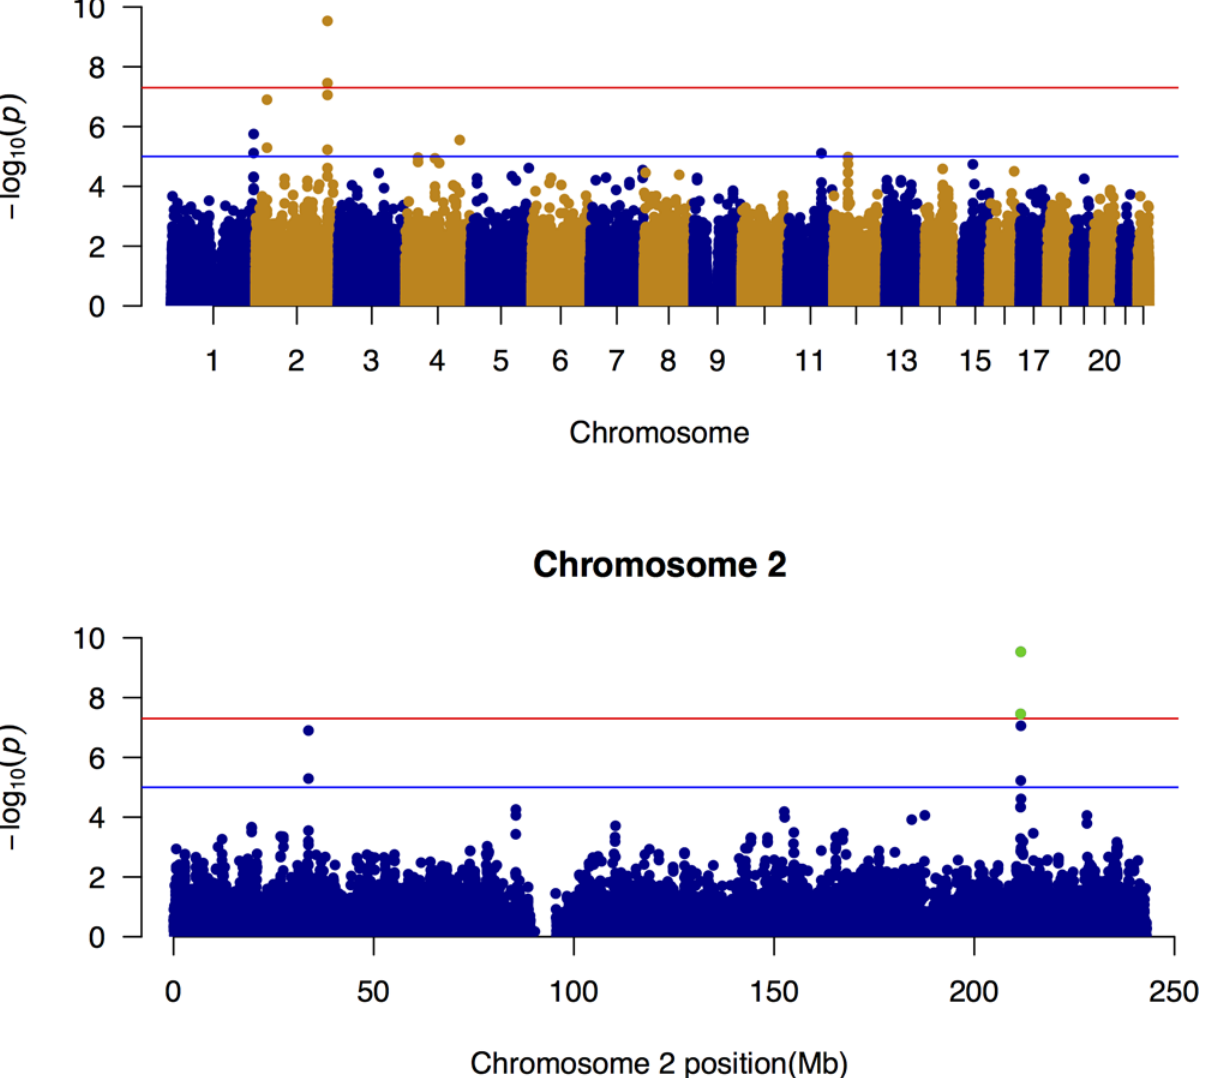
Fig 1. Manhattan plot of Glycine. (a) Genome-wide association of glycine and (b) zoom on chromosome 2. The two green dots represent the SNPs significantly associated with glycine levels: rs10206976 (chr 2:210749914) and rs12613336 (chr 2:210704675), in the CPS1 gene. Significativity (p — value = 5.0e-8) and suggestive (p — value = 1.0e-5) thresholds are provided as red and blue lines